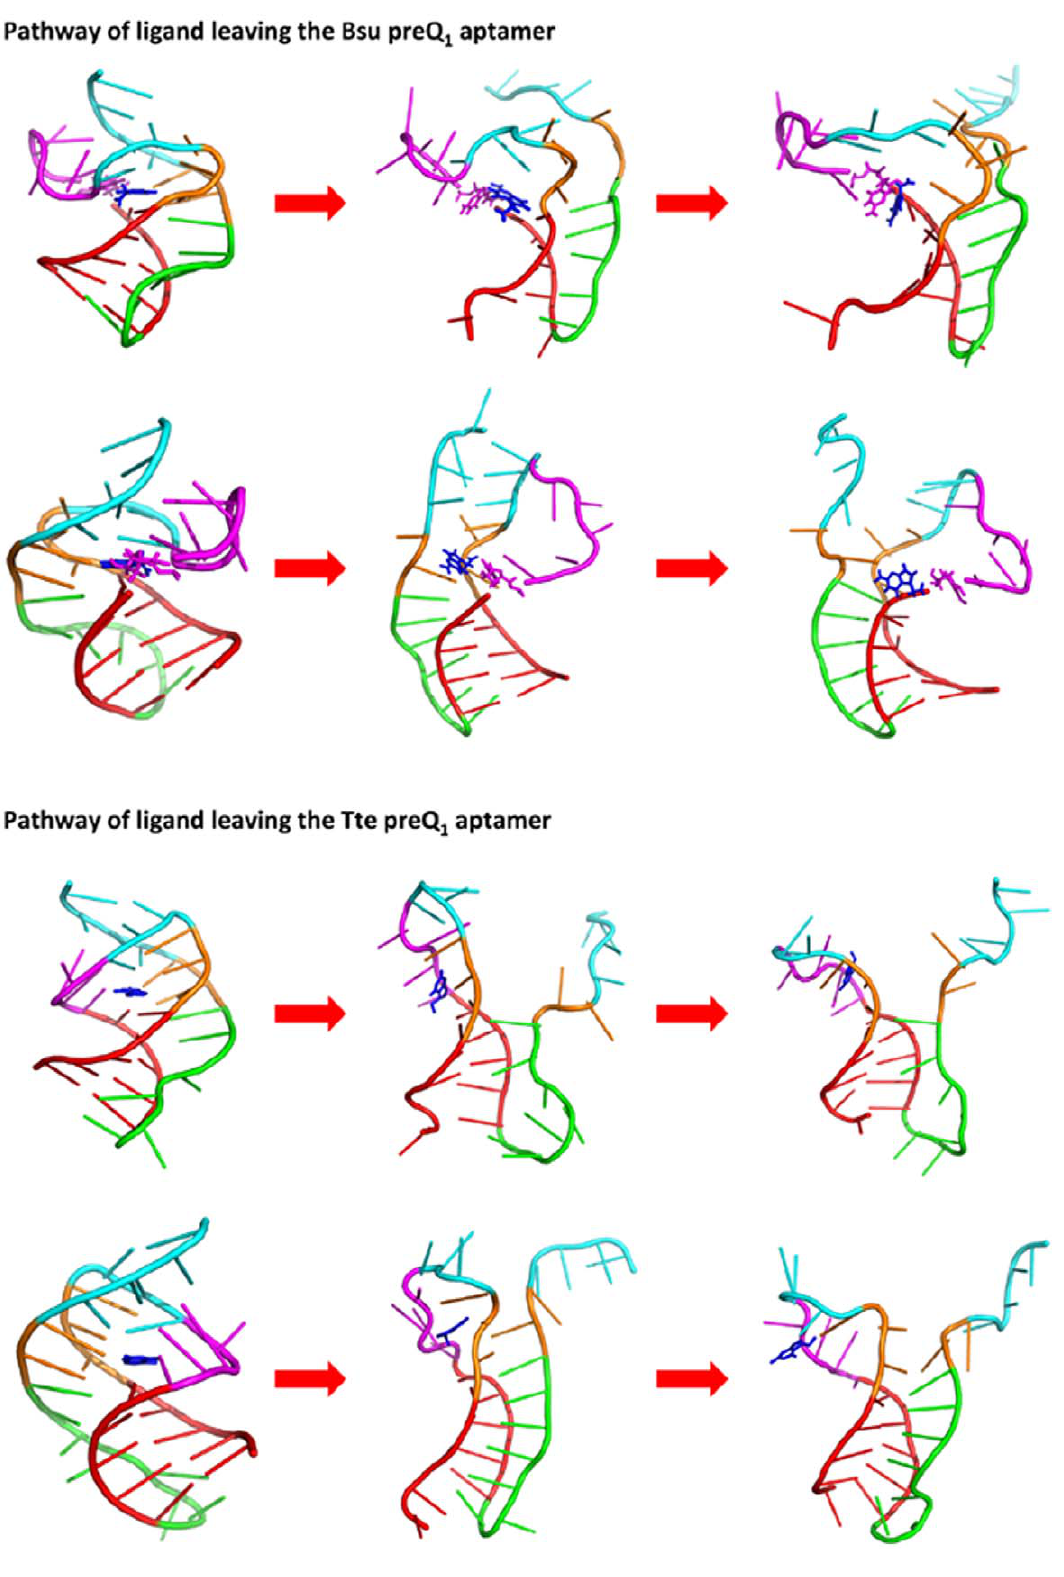
Figure 4. Two pathways for the ligand preQ 1 move away from the aptamers. Top: the major groove side of P1; Bottom: the minor groove side of P1.